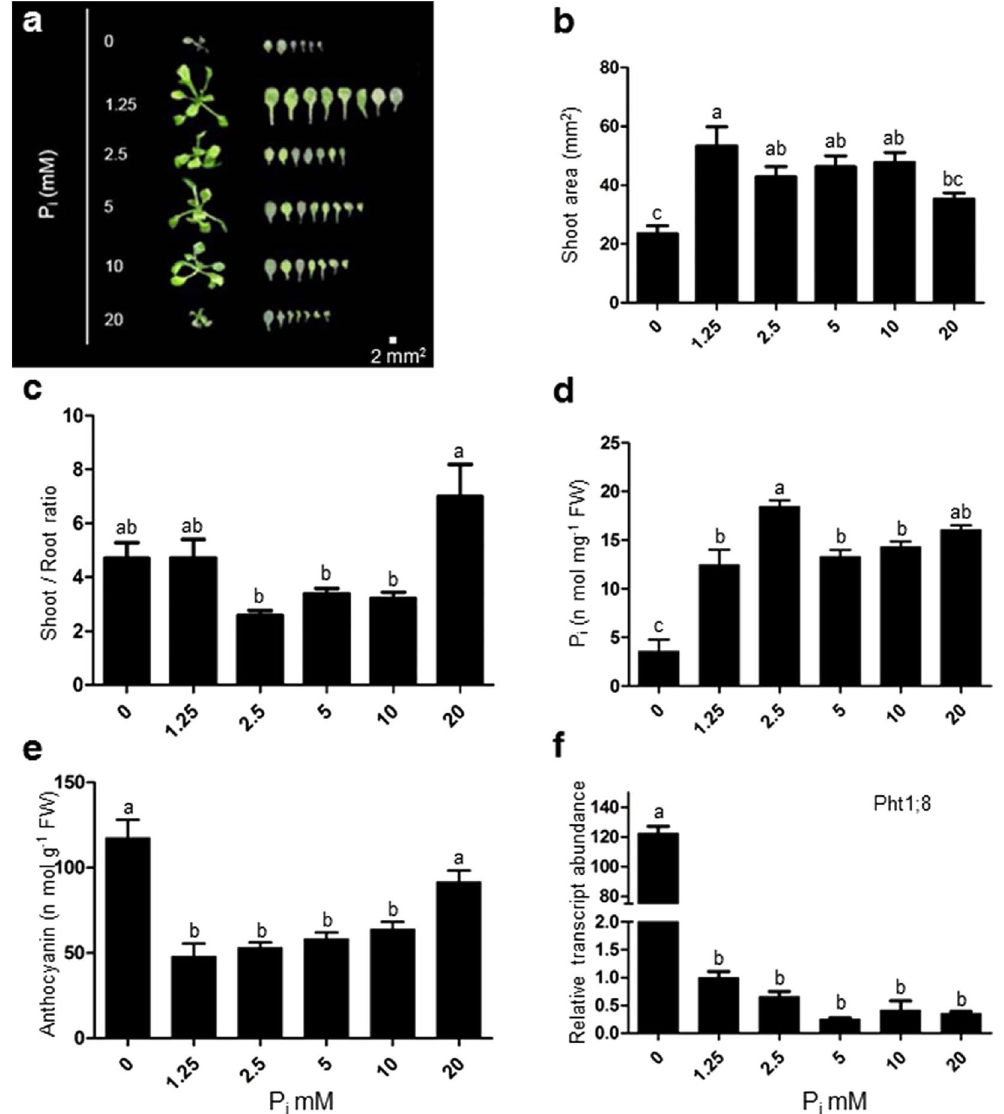
Figure 1. Supply of different concentrations of excess phosphate (P i ) modulates morphophysiological traits of the shoot. WT seedlings were initially grown hydroponically in 0.5X MS media for 5 days thereafter subjected to different P i supplies (0, 1.25, 2.5, 5, 10, 20 mM) and grown for 7 days. Seedlings were spread on the agar Petri- plates for measurement of traits ( a,b ). Data are presented for shoot area ( b ), shoot to root ratio ( c ), total soluble P i content ( d ), anthocyanin content ( e ), the expression level of Pht1;8 in shoot ( f ). Values are means ± SE, n = 21 ( b,c ), n = 3 consists of 30–70 mg shoot tissue in each assay ( d , and e ), n = 3 consists of 50 mg shoot tissue for each replicate ( f ). Mean Bars with different alpha letter differ significantly (P ≤ 0.05) according to analysis of variance (1X-ANOVA) with Tukey’s Multiple Comparison